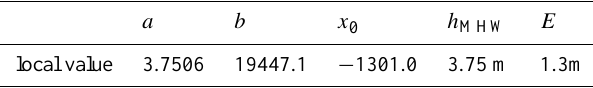
Table 1. Values used for the water surface elevation function h